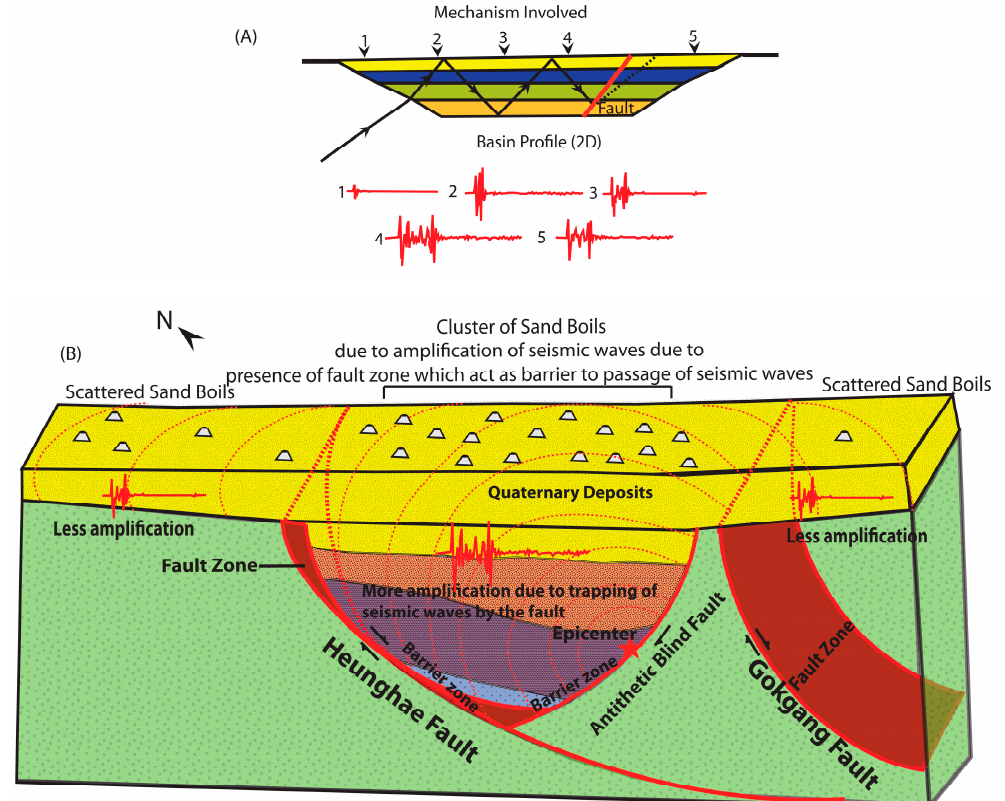
Figure 12. Conceptual models for the clustering of liquefaction during the Pohang earthquake. ( A ) Model for the mechanism involved in the localized amplification of seismic waves within a basin due to mountain basin effect. ( B ) Model for the mechanism explaining the role of the Heunghae fault in clusters of sand boils in the southern part of the fault. From the field survey and UAV image (Figure 3), it was clear that most of the sand boils were clustered densely in the southern part of the fault (model is not up to the scale).